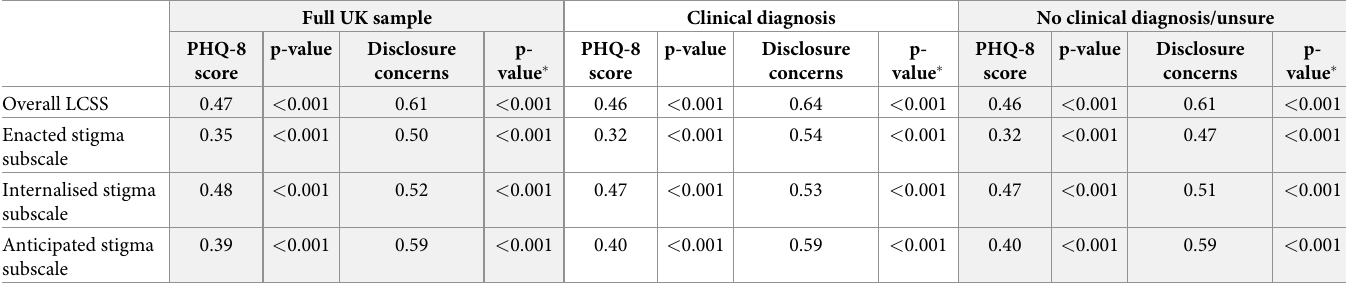
Table 4. Correlations between stigma scores, eight-item Patient Health Questionnaire (PHQ-8 score) and disclosure concerns.